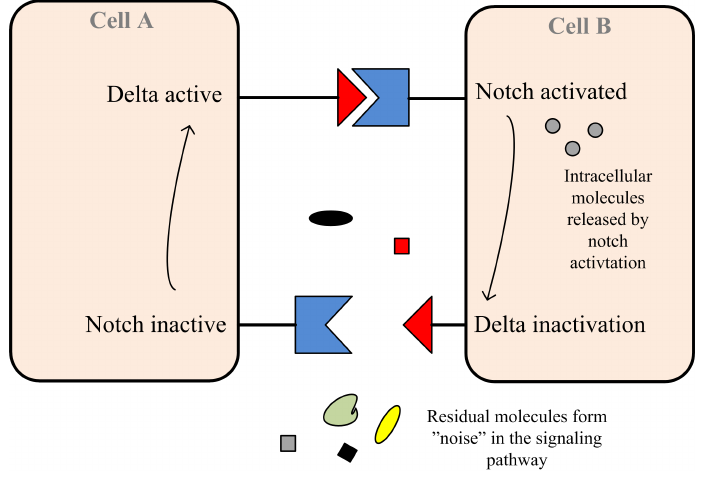
Figure 2. The delta-notch mechanism constitutes an effective feedback look between delta and notch ligands in neighboring cells (Adapted from [28] Figure